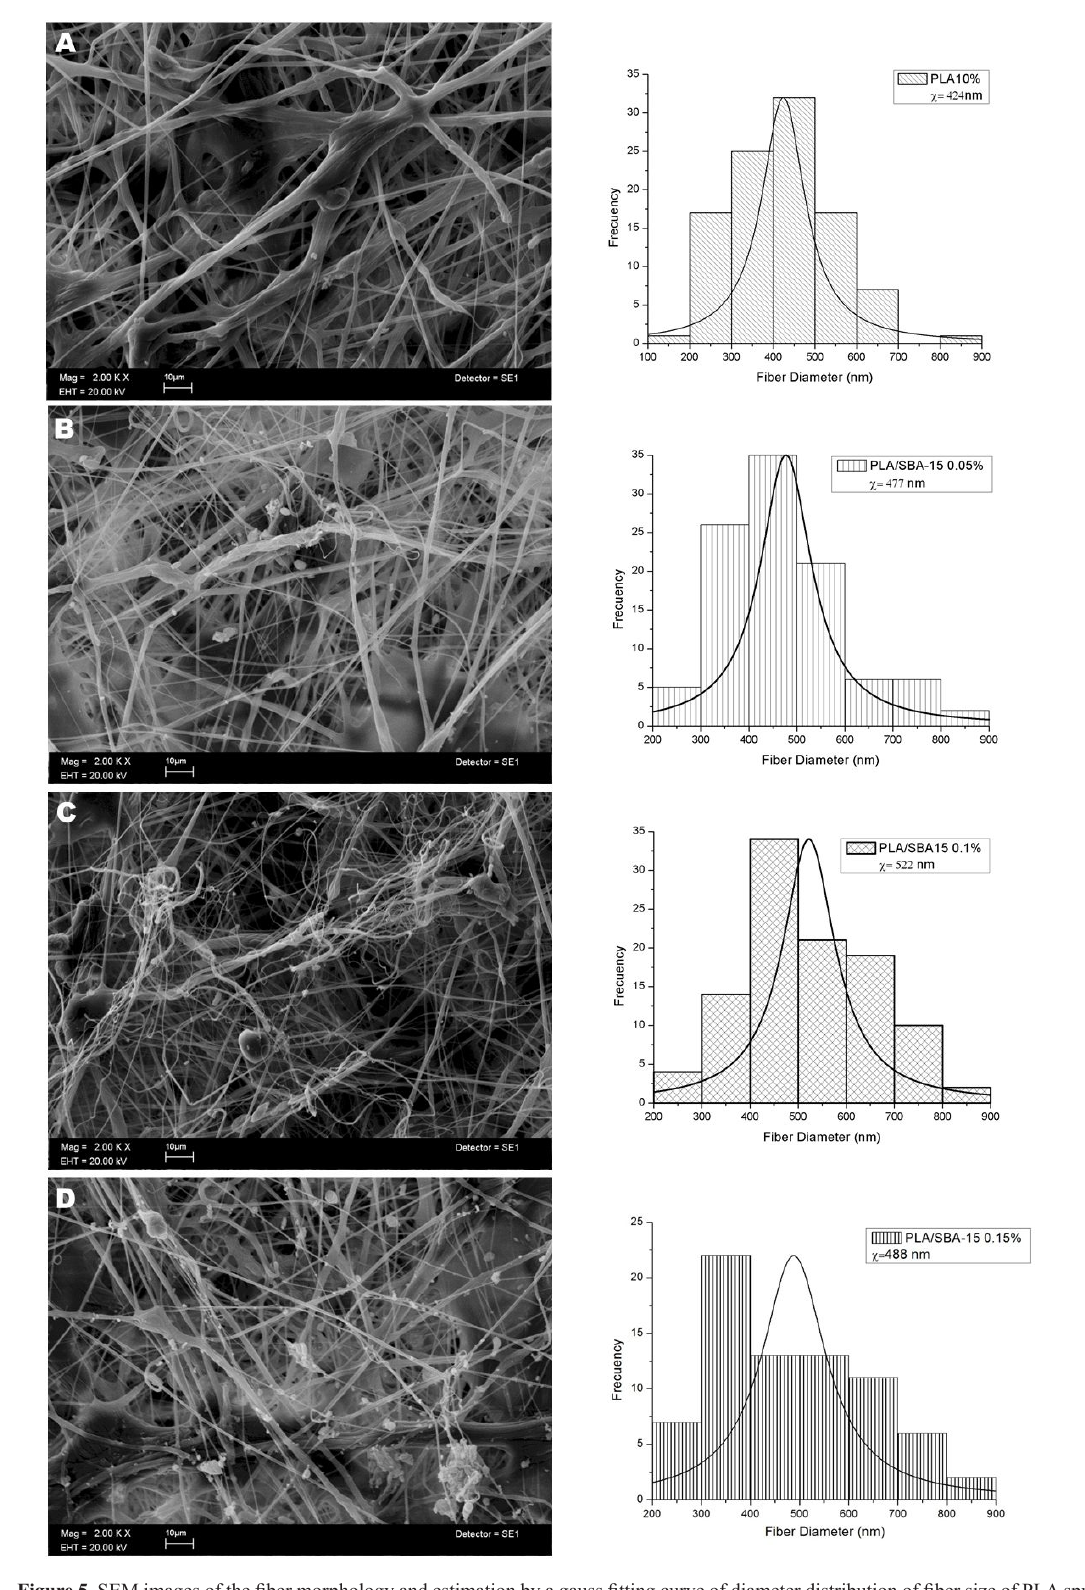
Figure 5. SEM images of the fiber morphology and estimation by a gauss fitting curve of diameter distribution of fiber size of PLA spun membrane of 10% (A) and PLA/SBA15 composite scaffold with 0.05% (B); 0.10% (C) and 0.15%